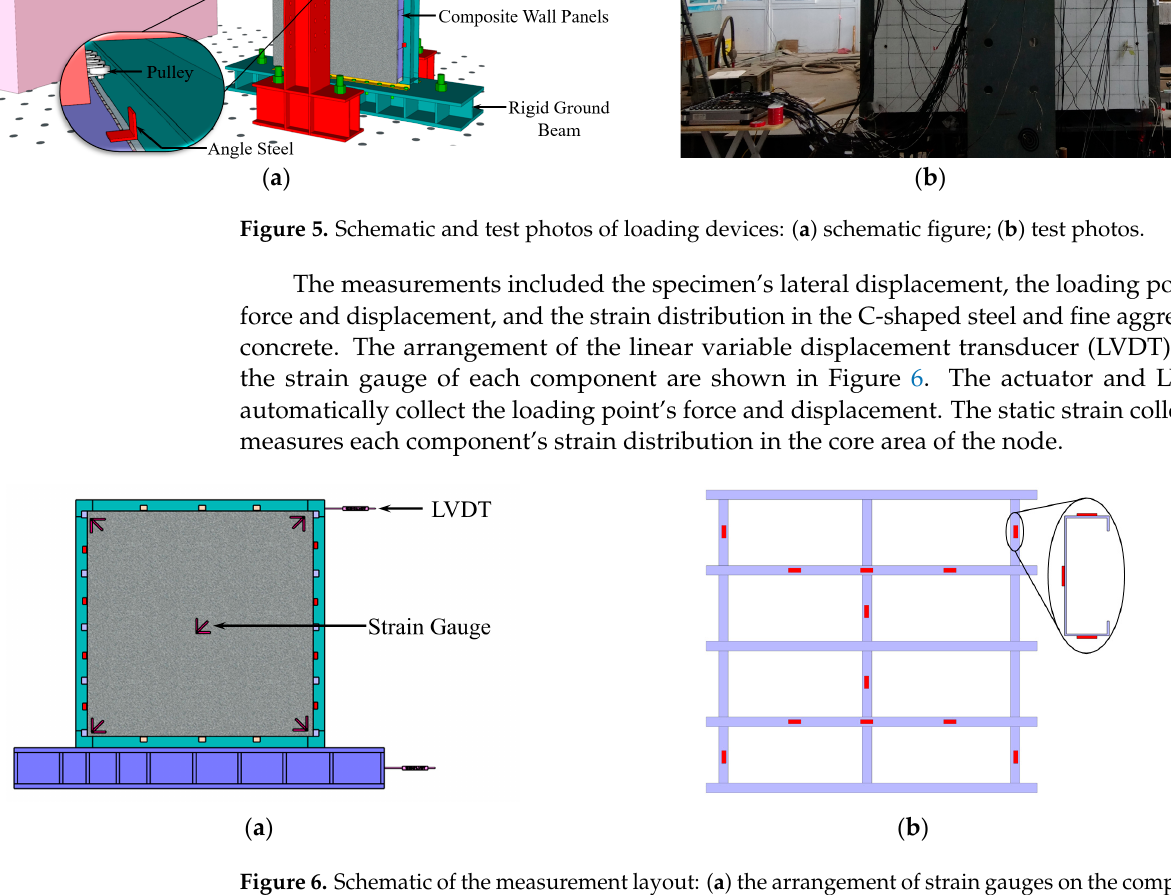
Figure 7. Loading protocol. 4. Test Results and Analyses 4.1. Test Phenomena and Failure Modes (1) WP-1 When the loading displacement was within 12 mm, there was no crack on the mortar and concrete surface, and the specimen was in the elastic stage. When the loading dis- placement reached 24 mm, 45° cracks appeared in the middle area of the mortar layer, and a vertical crack emerged at the junction between the side of the concrete layer and the C- shaped steel. When the loading displacement reached 30 mm, in the middle area of the fine aggregate concrete layer, 45° cracks appeared, and the vertical cracks extended up- ward. With the increase in displacement, the number and width of diagonal cracks in the